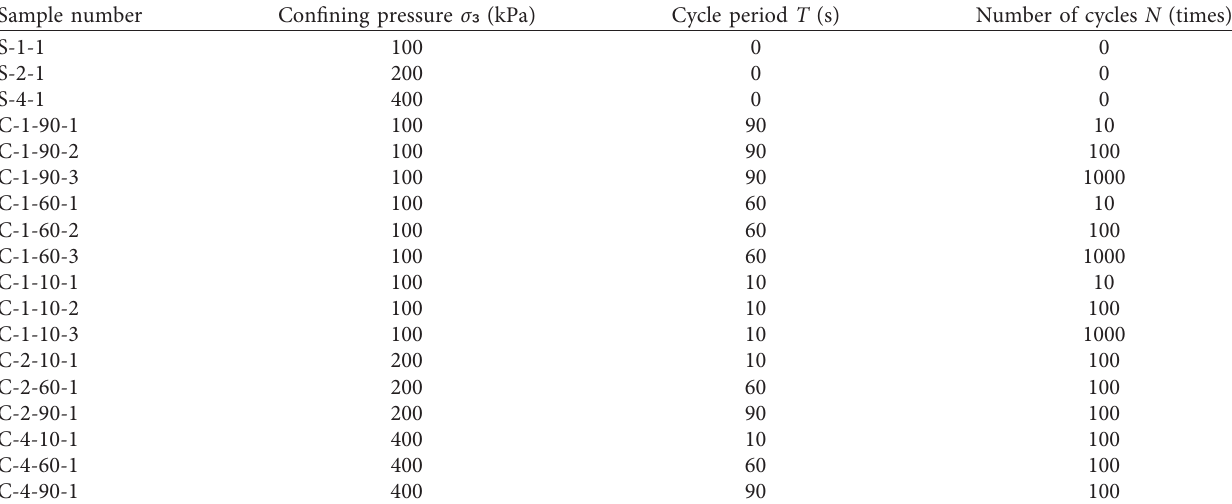
Figure 4: The KTL triaxial automated system. (a) Components of the triaxial compression apparatus. (b) Mounting of specimen. Table 2: Programme of the consolidated undrained triaxial compression